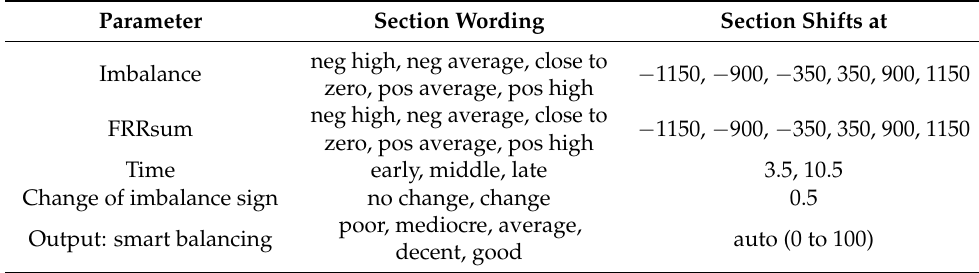
Table A2. Overview of profit optimization parameters of